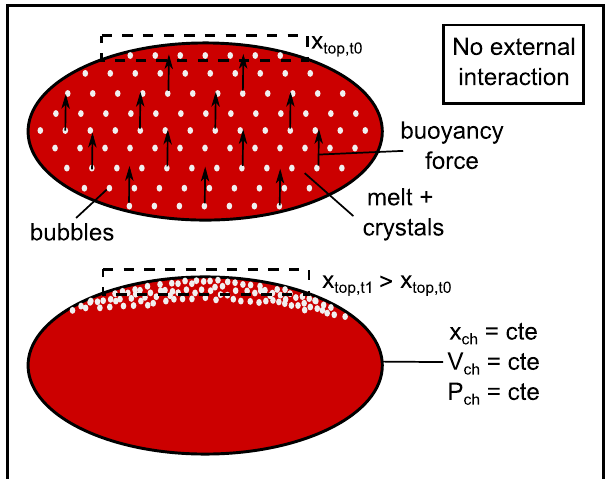
Fig. 1 Schematic representation of excess volatile accumulation at the top of the chamber due to bubble buoyancy. If the volatile saturation condition is met within the magma chamber, pre-eruptive bubbles start to nucleate and grow uniformly within the chamber (scenario at time t 0 ). After some time (t 1 > t 0 ), exsolved bubbles start to rise and accumulate at the top of the chamber due to buoyancy, creating an excess volatile region (x top,t1 > x top,t0 ). Since this is simply a mechanical movement of the bubbles inside the reservoir, the overall mean parameters within the chamber remain constant (such as the total volatile content, x ch , the volume of the ch amber, V ch , and the pressure, P ch